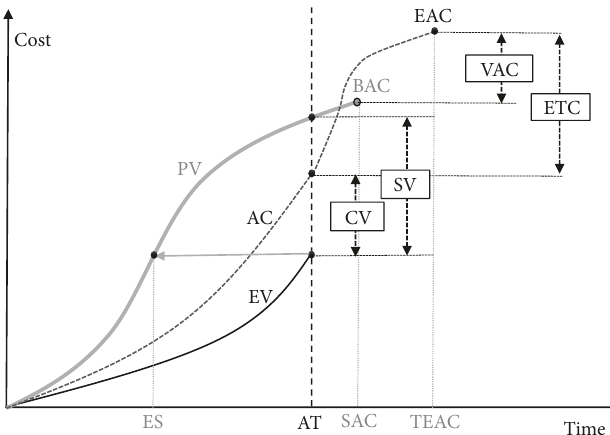
Figure 2: Cost/Time graph showing the main variables in the EVM and Earned Schedule techniques.